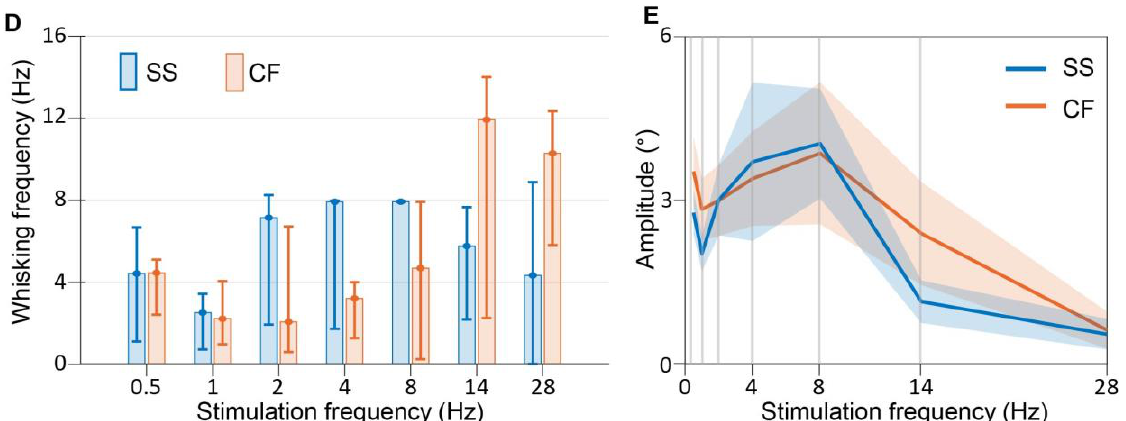
Figure 3. Purkinje cell stimulation induces whisker movements at the preferred frequency of 8 Hz. ( A ) shows mean ipsilateral whisker traces during SS stimulation (blue light) in the paramedian lobule on the right hemisphere. Vertical blue bars represent stimuli, lines represent mean, and the shaded areas display ± SEM (n = 6 mice). ( B ) is similar to ( A ), but for climbing fiber stimulation (n = 8 mice). ( C ) shows normalized whisker power spectra during the stimulation. The stimulation frequencies of each plot is the same indicated on the left part of panel ( A ). Also here, the lines represent the mean, and shaded areas indicate ± SEM. ( D ) shows a bar plot of the frequency at which the power spectra peaked when different frequencies were given (indicated on the x axes). ( E ) shows a psychometric curve of the amplitude of the whisker movement relative to the stimulation frequency. Note that the whisker movements were maximal within the theta-band (4–8